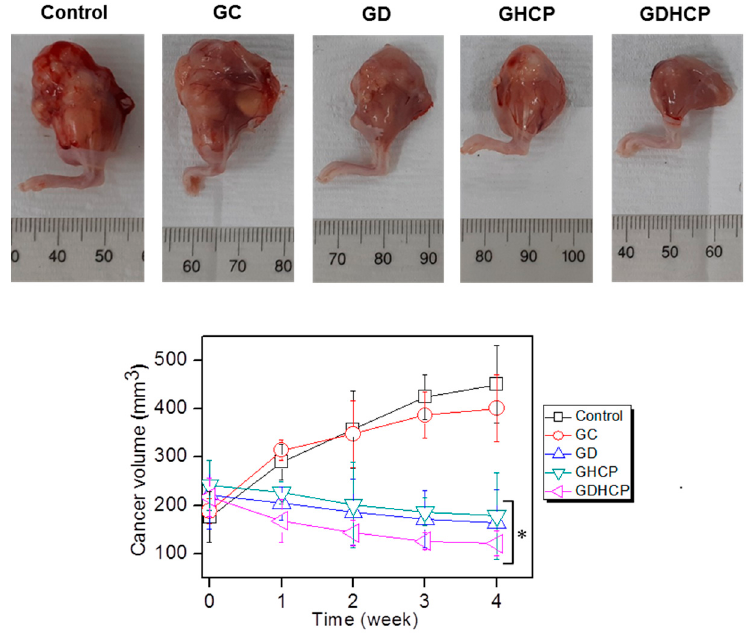
Figure 4. (Top) Gross appearances of cancer bearing to the femoral lesion of control, GC, GD, GHCP and GDHCP observed at 4 weeks after intratumoral injection. The injection was performed once a week for 4 weeks. (Bottom) Cancer volumes in control, GC-, GD-, GHCP- and GDHCP-treated mice ( # p < 0.05). The significance was compared with the